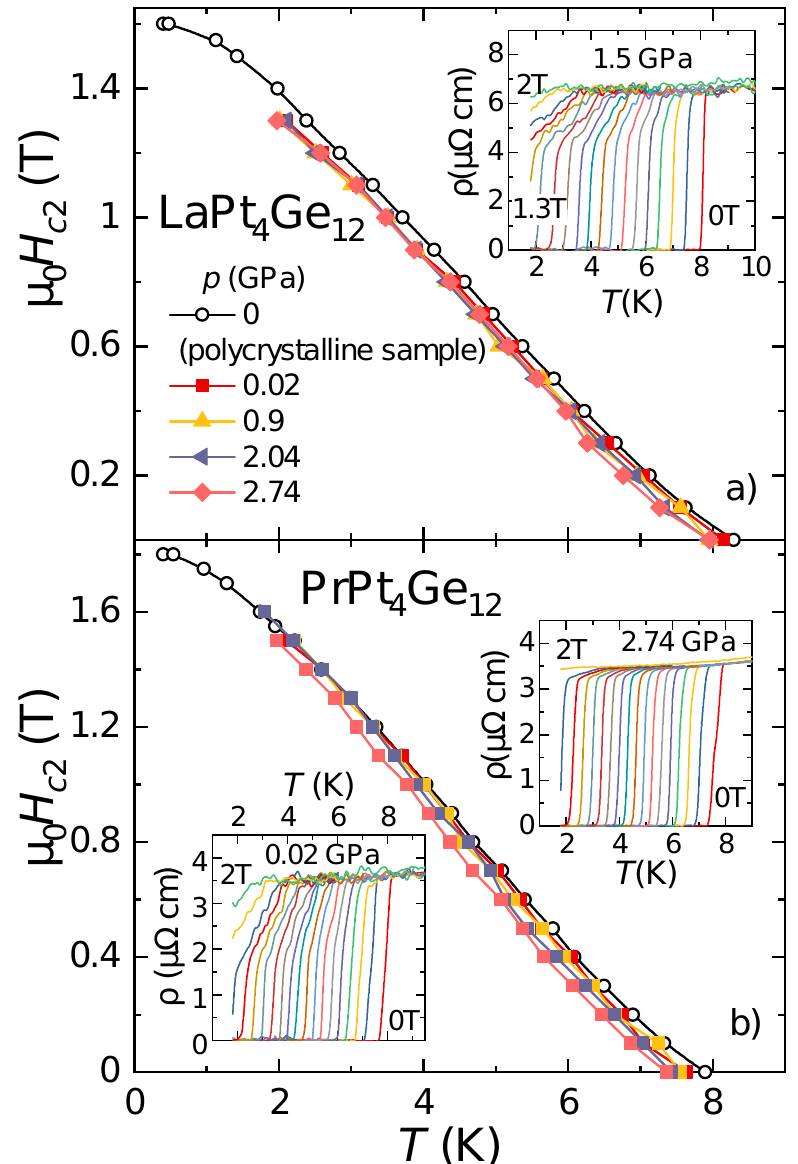
Figure 2. Magnetic field–temperature phase diagram of ( a ) LaPt 4 Ge 12 and ( b ) PrPt 4 Ge 12 single crystals at different pressures. The open symbols represent results of resistivity measurements at p = 0 on polycrystalline samples down to 350 mK using the Helium-3 option of a PPMS. The lines serve as guide to the eyes. The insets show the resistivity data in different magnetic fields for selected pressures as